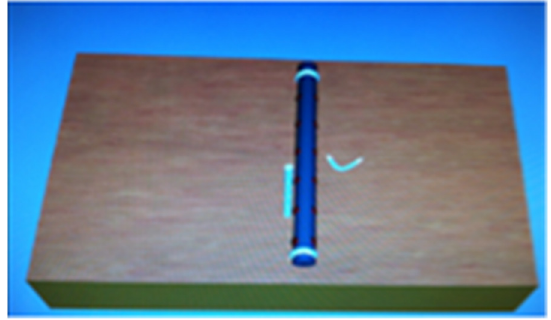
Figure 1. Needle passing